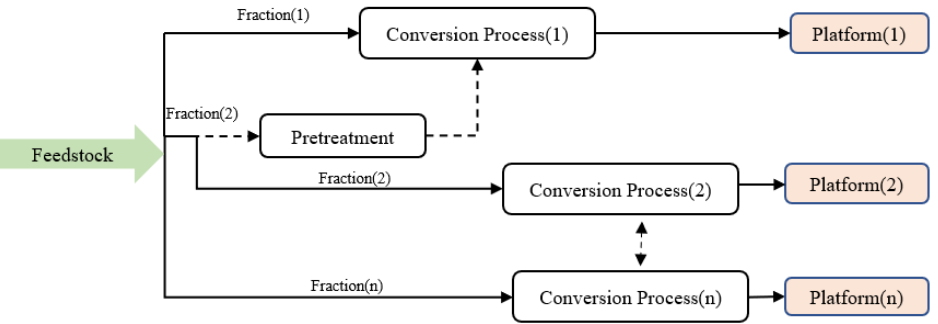
Figure 9. An illustration for biorefinery integration by platform. Table 3. Examples of biorefinery integration to produce two or more platforms. Feedstock